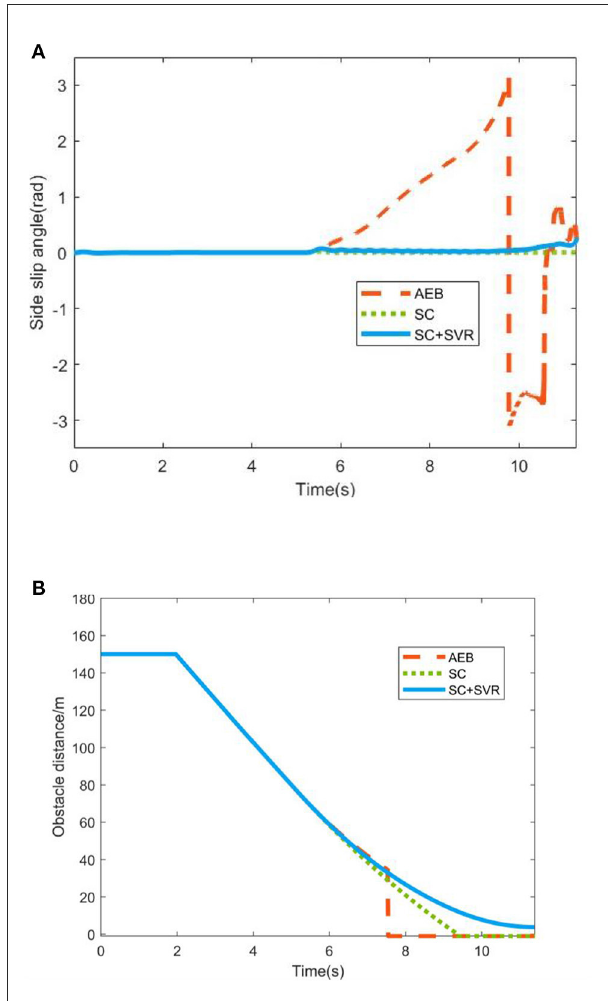
FIGURE15 Simulation results. (A) The sideslip angle of three working conditions. (B) The obstacle distance of three working